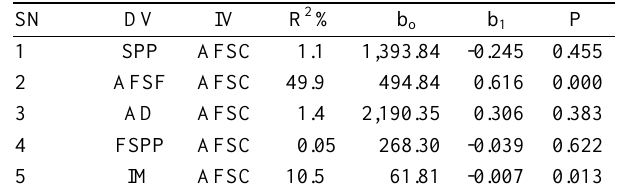
Table 8. Regression coefficient (b o , b I ) and coefficient of determination (R 2 ) along with respective probability values for different male reproduction parameters using AFSC as the dependent variable in crossbred cattle